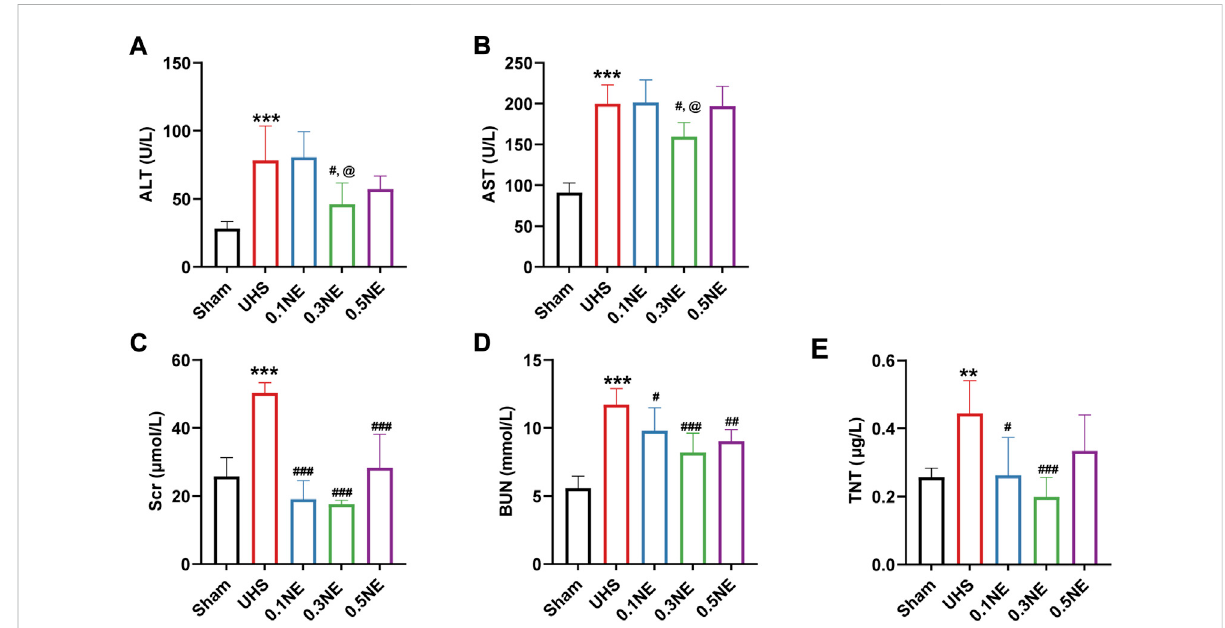
FIGURE 4 The effect ofNEon vital organ functions following prolonged golden treatment time for 2 h. (A) ALT. (B) AST. (C) Scr. (D) BUN. (E) TnT.** p 0.01, *** p ＜ 0.001 as compared with the sham group; # p ＜ 0.05, ## p ＜ 0.01, ### p ＜ 0.001 as compared with the UHS group; @ p ＜ 0.05 as compared with the 0.1 NE group.